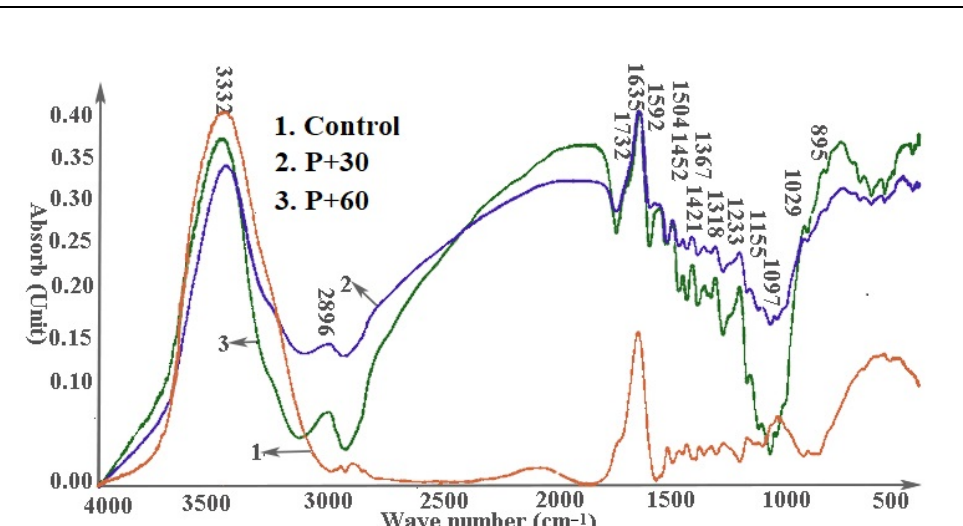
Figure 6. Effect of pectinase pretreatment on FTIR spectra of a 70:30 wood/hemp hurd fiber mixture.